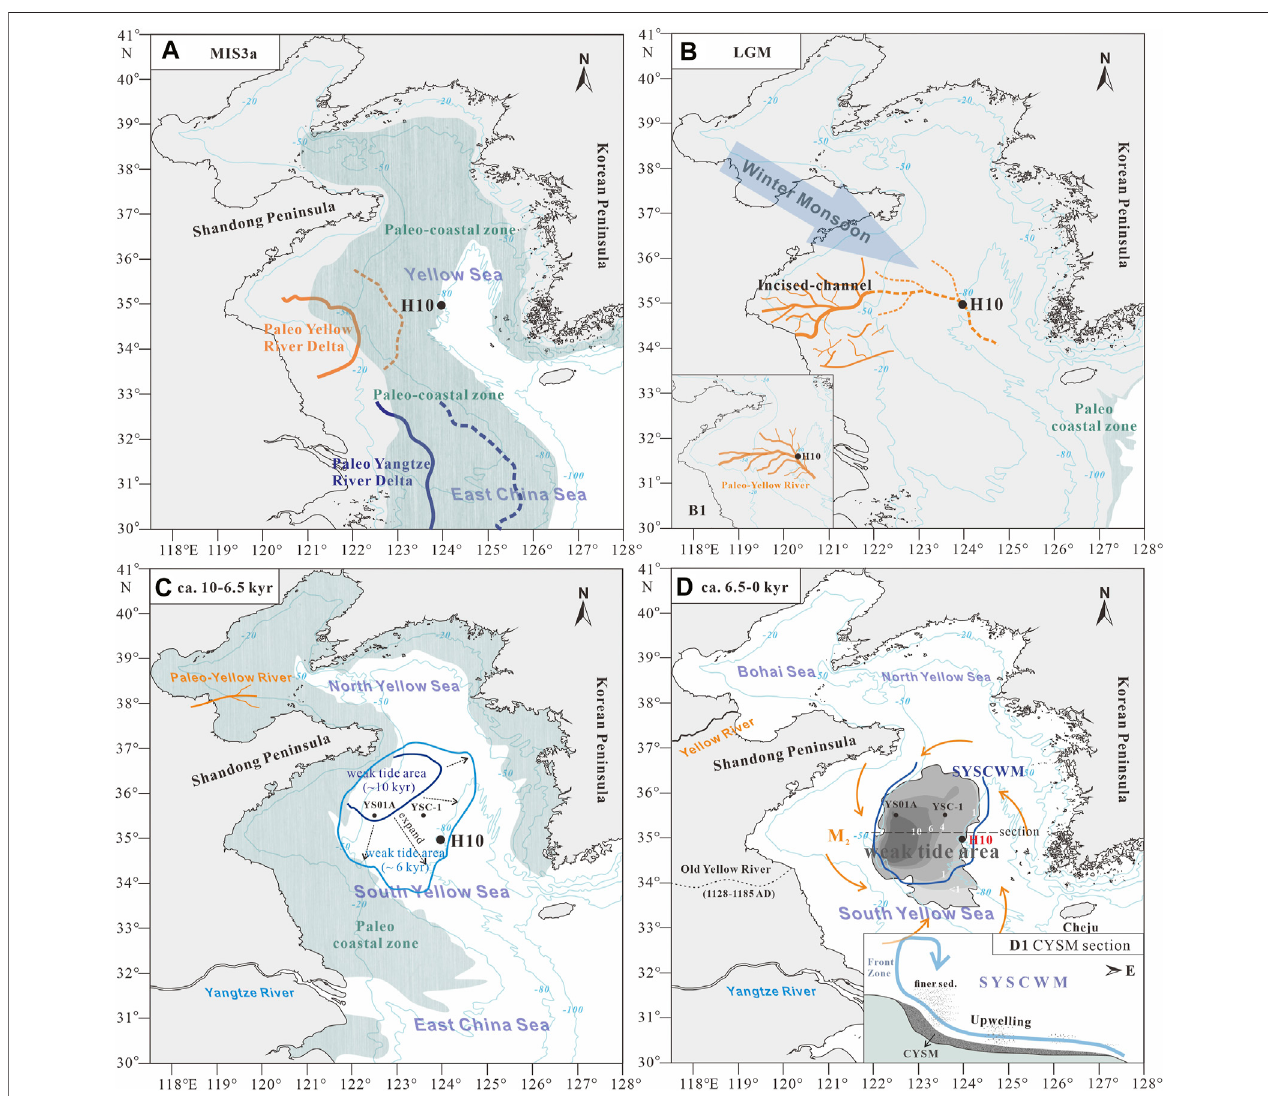
FIGURE 9 | Schematic diagrams for variation of coastal lines (Li et al., 2014a), distribution of paleo-rivers (Liu et al., 2002; Wellner and Bartek, 2003; Liu et al., 2010a;Songetal.,2016),evolutionofhydrodynamicregimes(UeharaandSaito,2003;Lüetal.,2010;Wangetal.,2014a),andformationoftheCYSM(mudthicknessis from Wang et al., 2014b) in the South Yellow Sea during MIS3a (A) , LGM (B) , ~10 – 6.5 kyr (C) , and 6.5 kyr — present (D) . The dotted line represents the inferred paths andranges.Thebluelinesareallmodernwaterdepths.MIS,marineisotopestage;LGM,LastGlacialMaximum;CYSM,centralYellowSeamud;SYSCWM,South Yellow Sea Cold Water